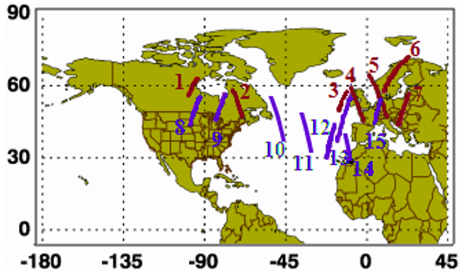
Figure 5. Map showing the relevant CALIPSO overpasses tracking some smoke plumes being transported to Europe. Brown lines stand for plumes arriving at Warsaw on 9 July 2013, and purple lines stand for plumes arriving at Granada on 14 July 2013 and Leipzig on 17 July